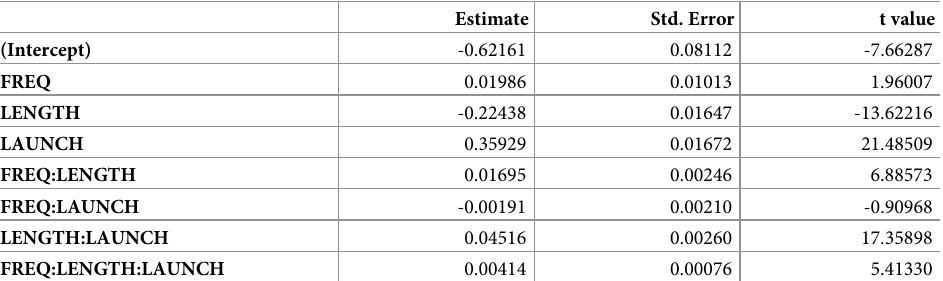
Table 7. Fixed effects of optimal LMM for within-word initial landing